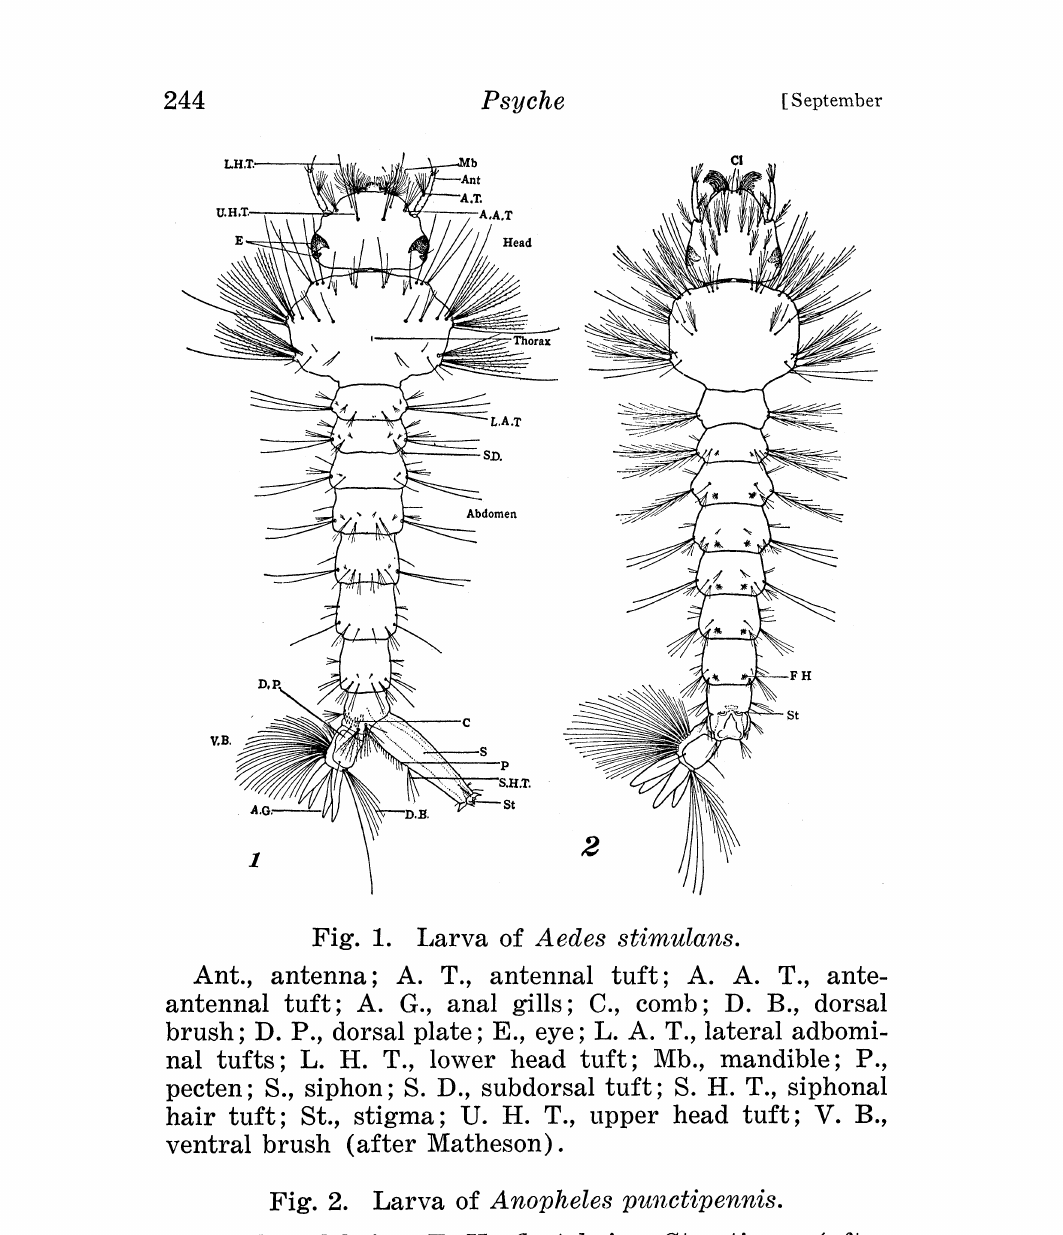
Fig. 2. Larva of Anopheles punctipennis. CI., clypeal hairs; F. H., float hairs; St., stigma